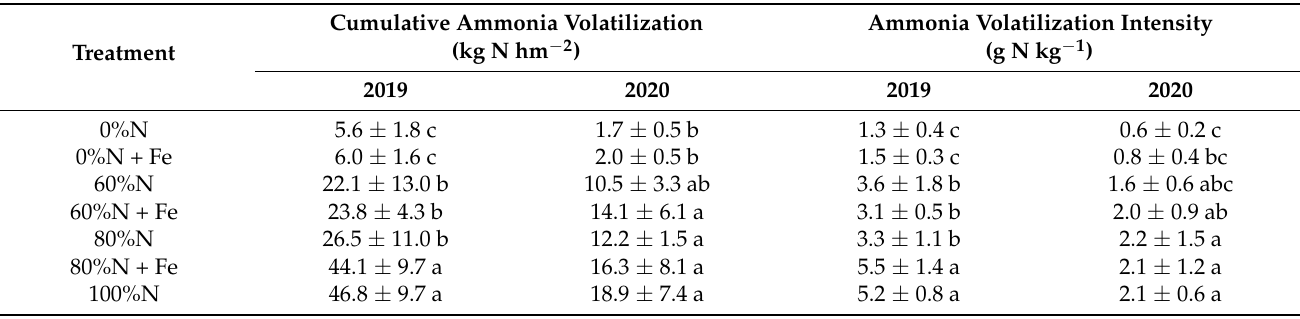
Table 2. Cumulative ammonia volatilization and ammonia volatilization intensity under various nitrogen fertilization rates with or without iron amendment in two rice-growing